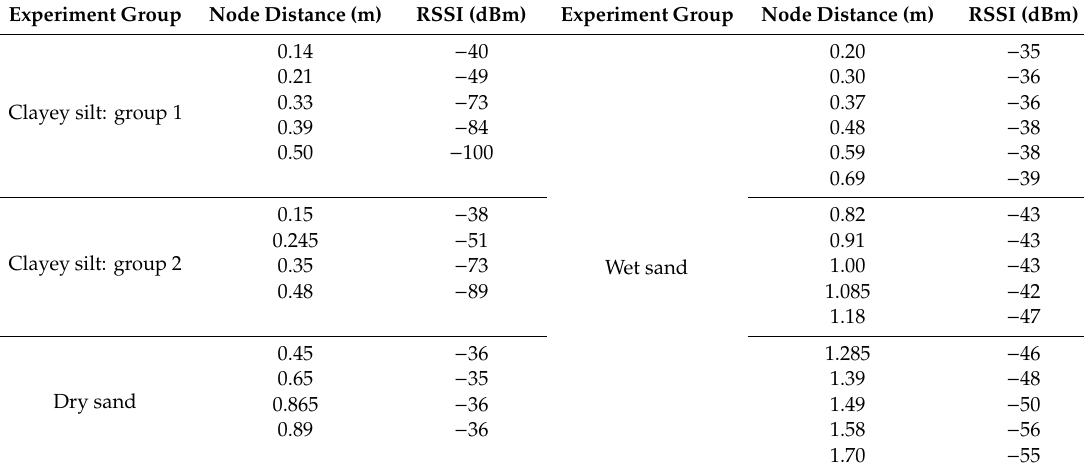
Table A1. Experiment data acquired in this